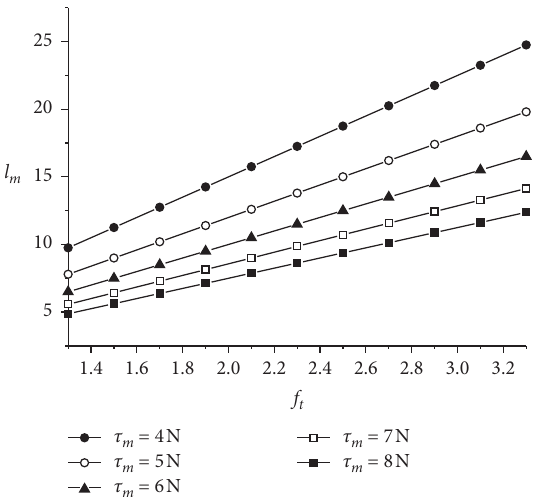
� 30 t and l m ( R c